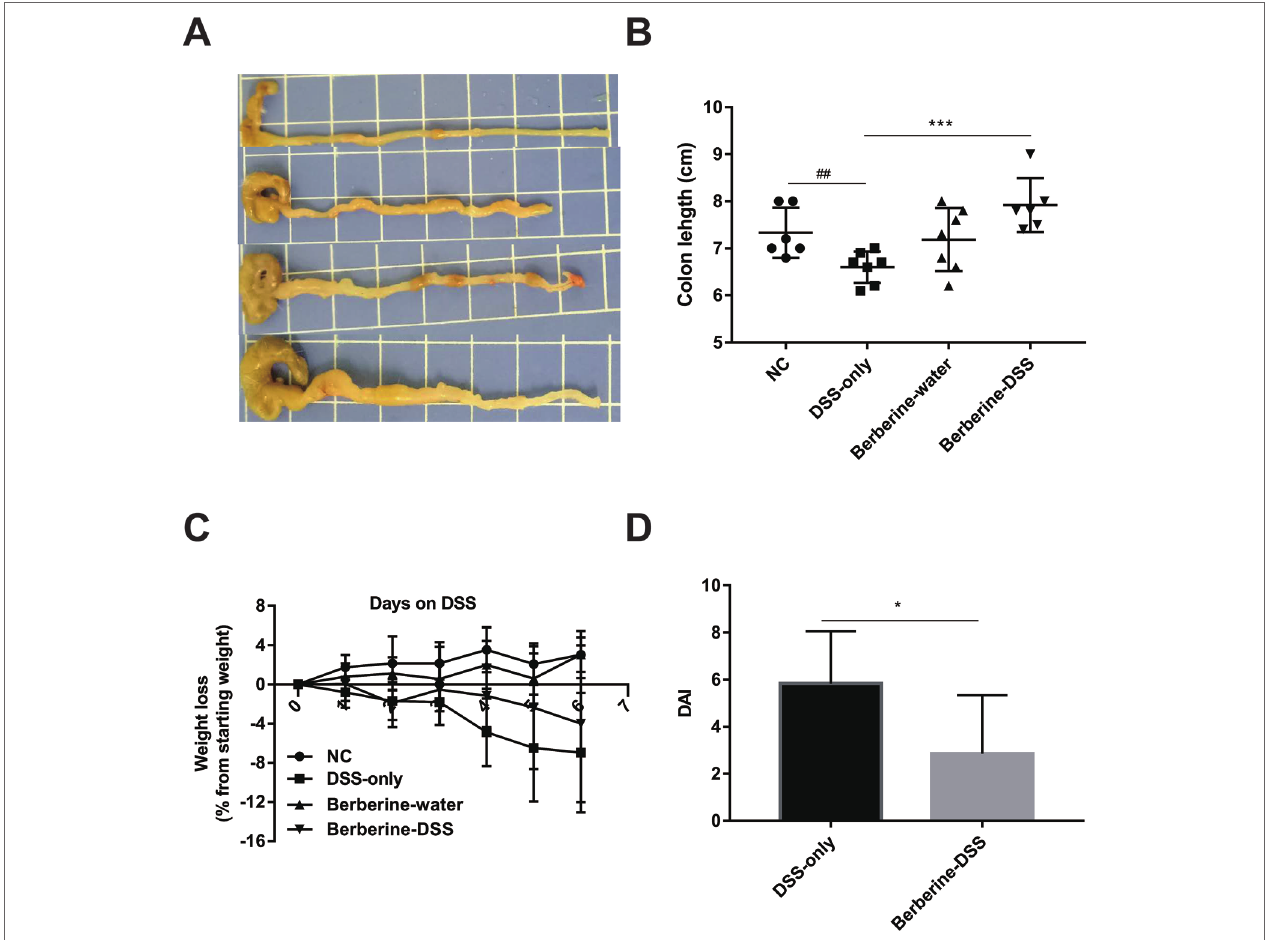
FIGURE 1 | Berberine attenuated dextran sulfate sodium (DSS)-induced colitis. The pictures of colon (A) , colon length (B) and DAI (D) were determined on day 6 post DSS administration, and weight loss (C) was calculated daily. Data were pooled from two independent experiments with n = 7 mice per group. * P < 0.05, *** P < 0.001 and ## P <